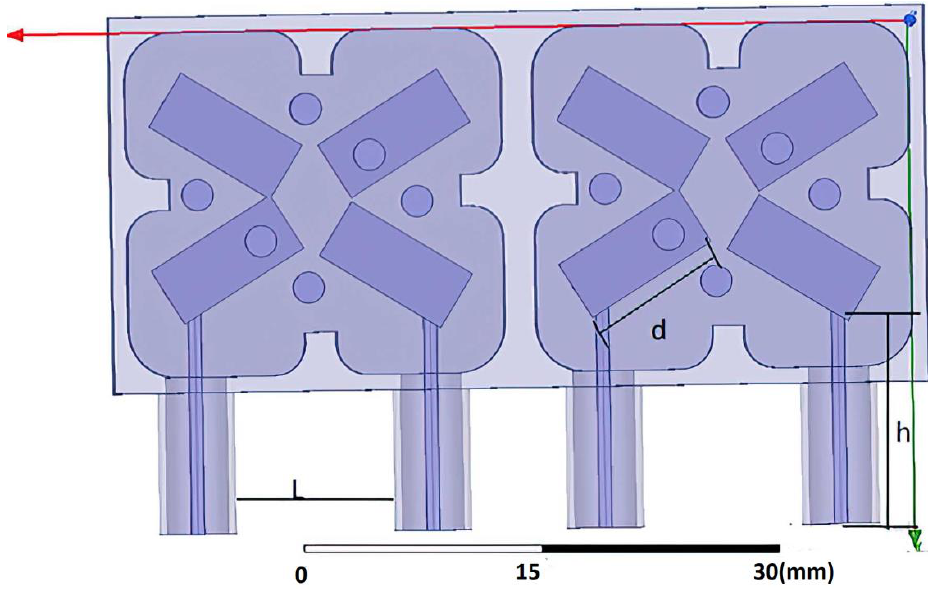
Table 1. Dimensional parameters of four-pole quad-mode resonator.